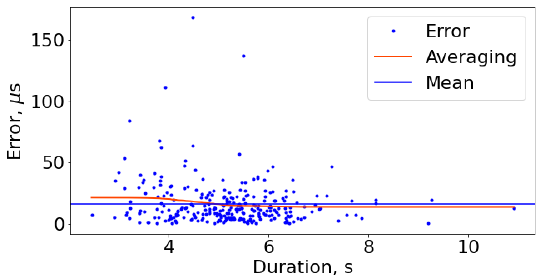
Figure 8. Duration/error dependence statistics of 277 trials with 188 Hz ILPF cut-off frequency. Averaging is carried out by Gaussian filter with deviation of the kernel equals 50. Averaged error (the red line) is slightly higher than the mean value (the blue line) for trials with the shorter duration; at the duration increase, the average lies lower than the mean and has the same value starting from 6 s. Still, there is no strong dependence of error value on the duration of